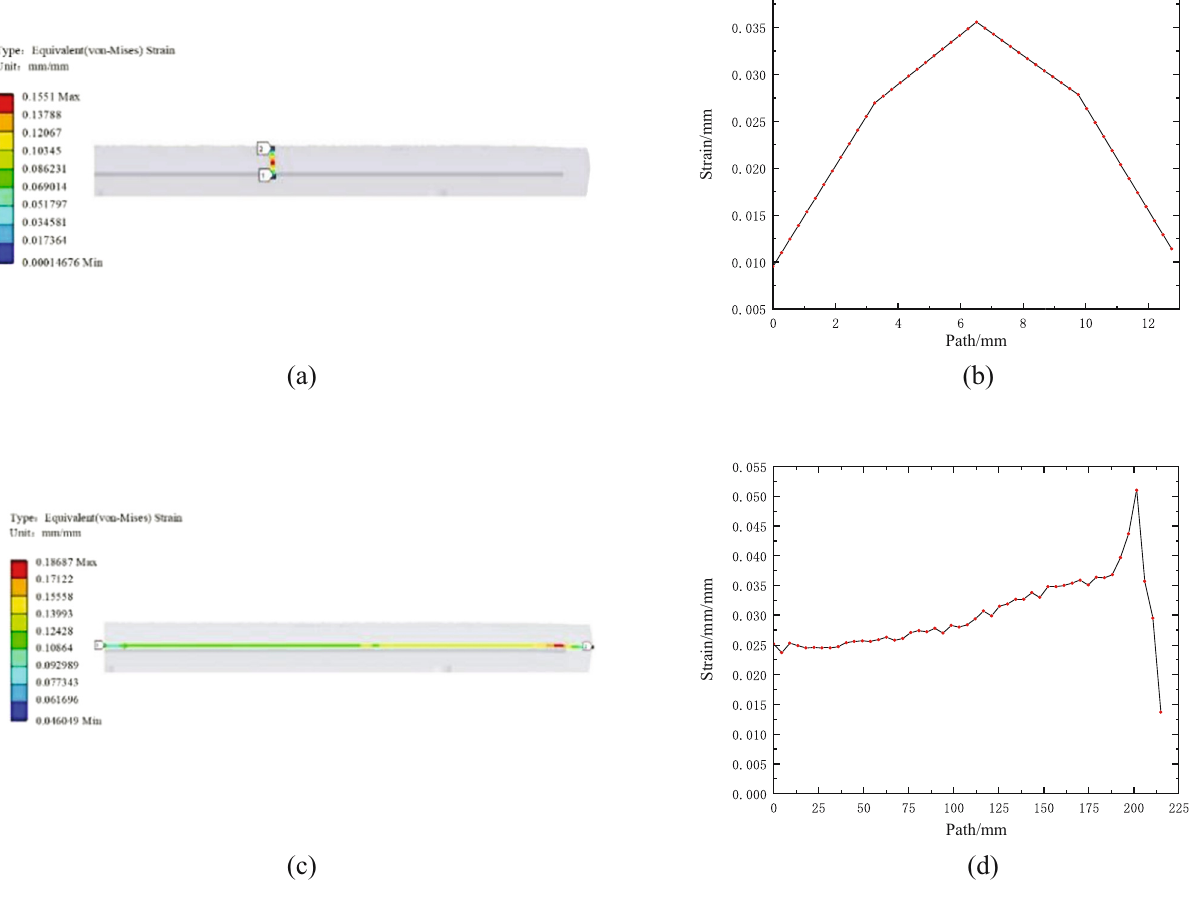
Figure 9: Strain analysis of FBG distribution path in the rubber stave: ( a ) radial strain tracking path, ( b ) strain along the radial path, ( c ) axial strain tracking path, and ( d ) strain along the axial